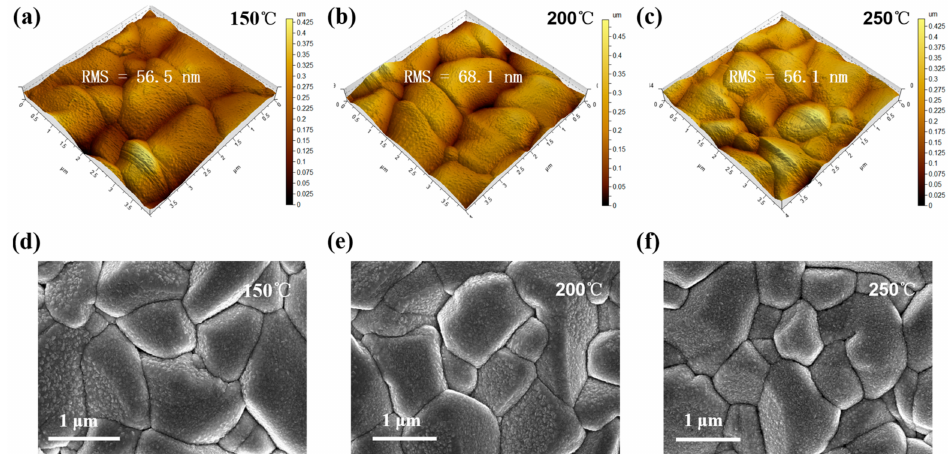
Figure 3. Top-view images of the ZnO films on the CZTSSe absorbers prepared at annealing tempera- tures of 150, 200 and 250 ◦ C: ( a – c ) AFM images; ( d – f ) SEM images.